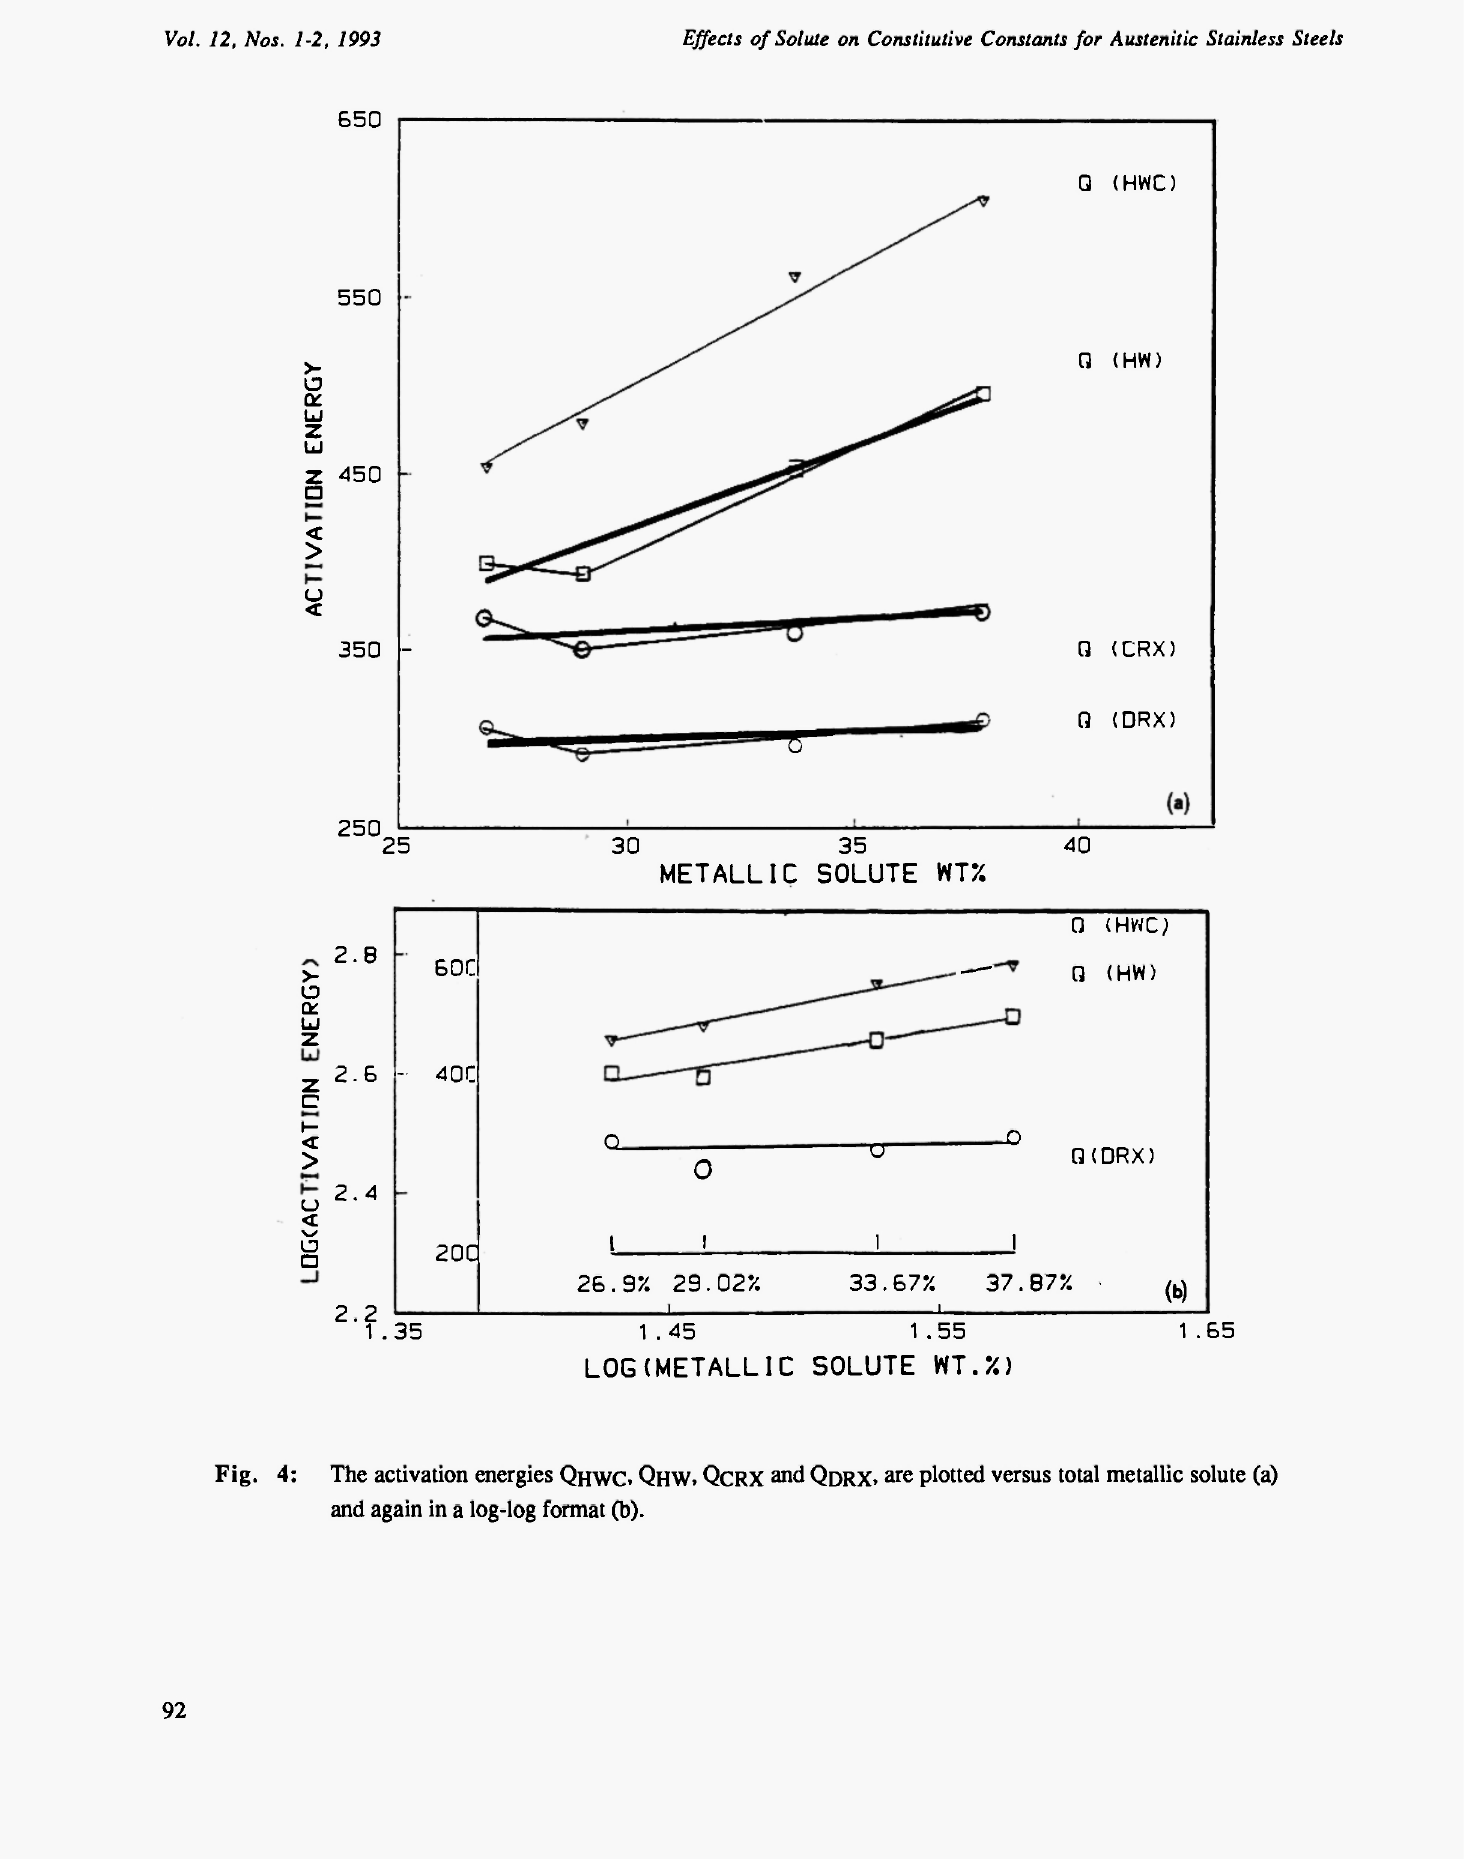
Fig. 4: The activation energies QHWC. QHW. QCRX AND QDRX. ARE plotted versus total metallic solute (a) and again in a log-log format